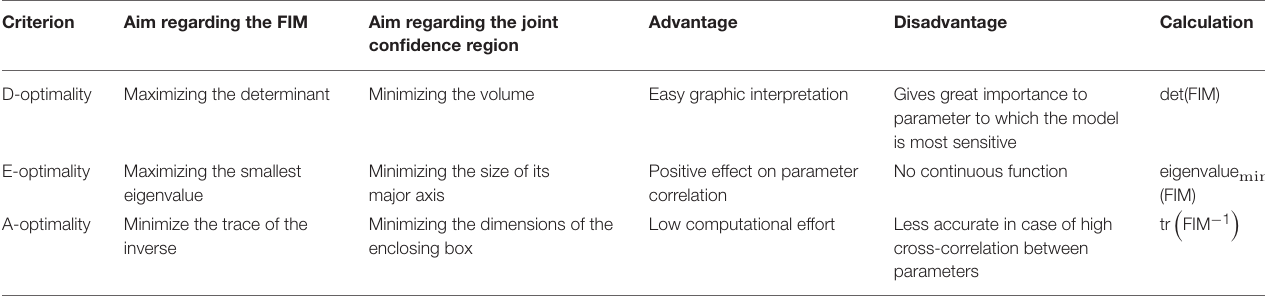
TABLE 1 | Characteristics of the standard optimal experimental design criteria.